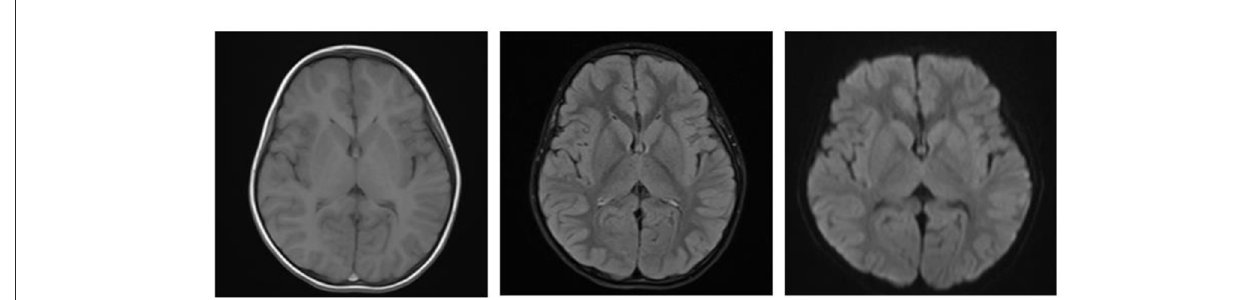
FIGURE1 Cranial MRI on admission.